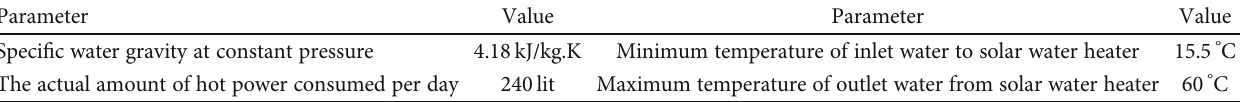
Table 1: Data to calculate the amount of heat required to supply the hot water consumption.